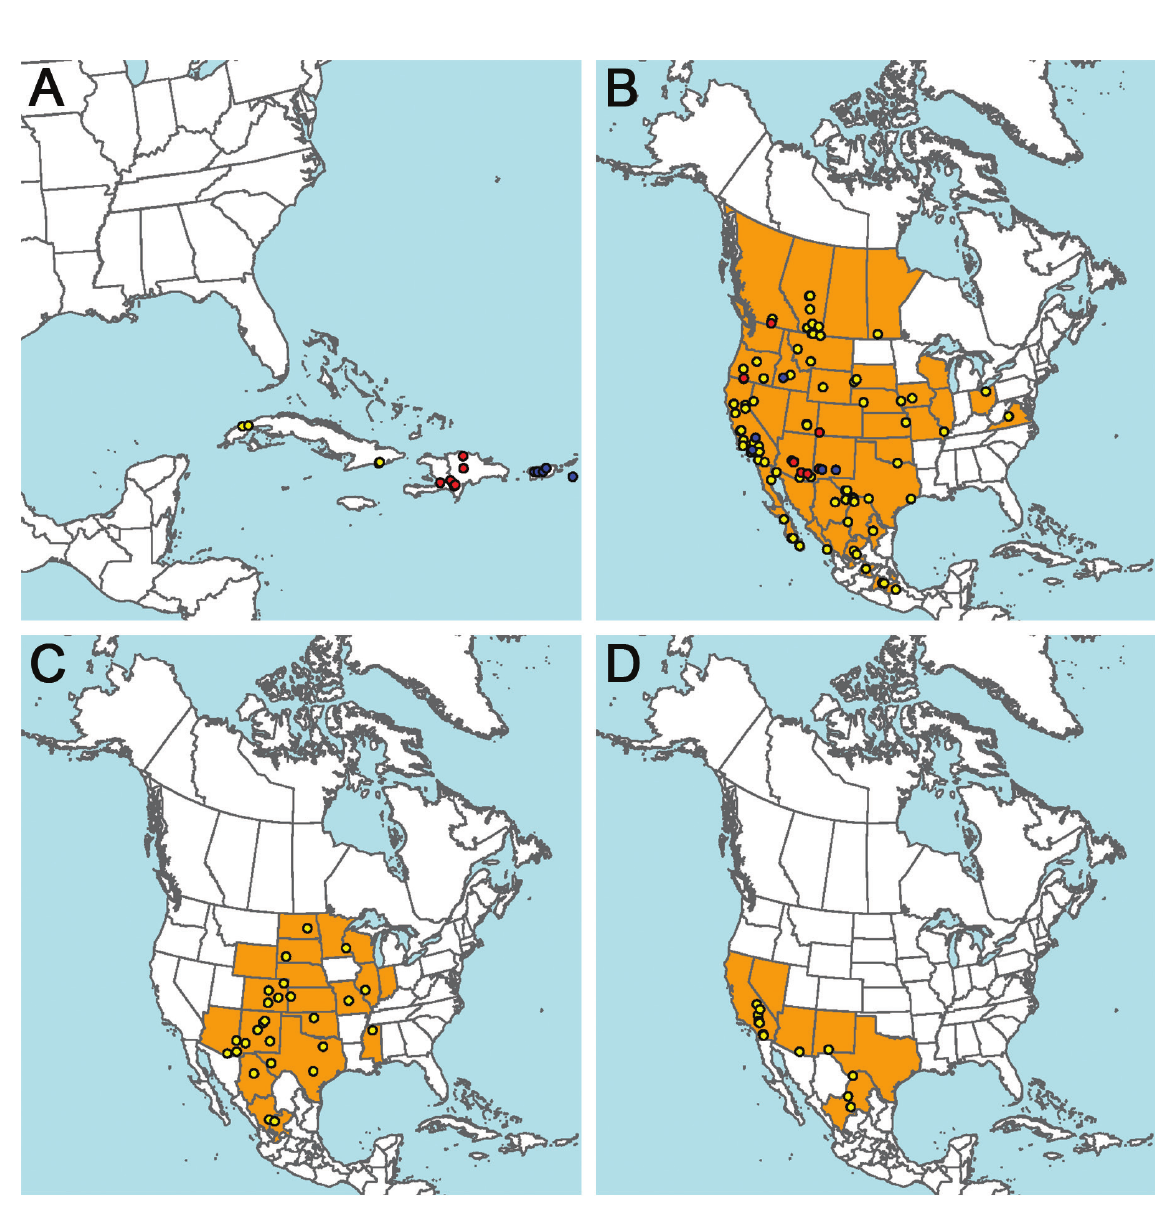
Fig. 4. Species distribution maps. A . Brachymelecta alayoi (Michener, 1988) (yellow circles), B. haitensis (Michener, 1948) (red circles), and B. tibialis (Fabricius, 1793) (blue circles). B . B. californica (Cresson, 1878) (red and blue circles indicate barcoded specimens assigned BINs BOLD:AAC6481 and BOLD:AAC6482, respectively). C . B. interrupta (Cresson, 1872). D . B. larreae (Cockerell, 1900). Known localities based on studied material and literature records are indicated by yellow circles except where indicated otherwise; subnational entities colored in orange indicate known/published provincial/ state